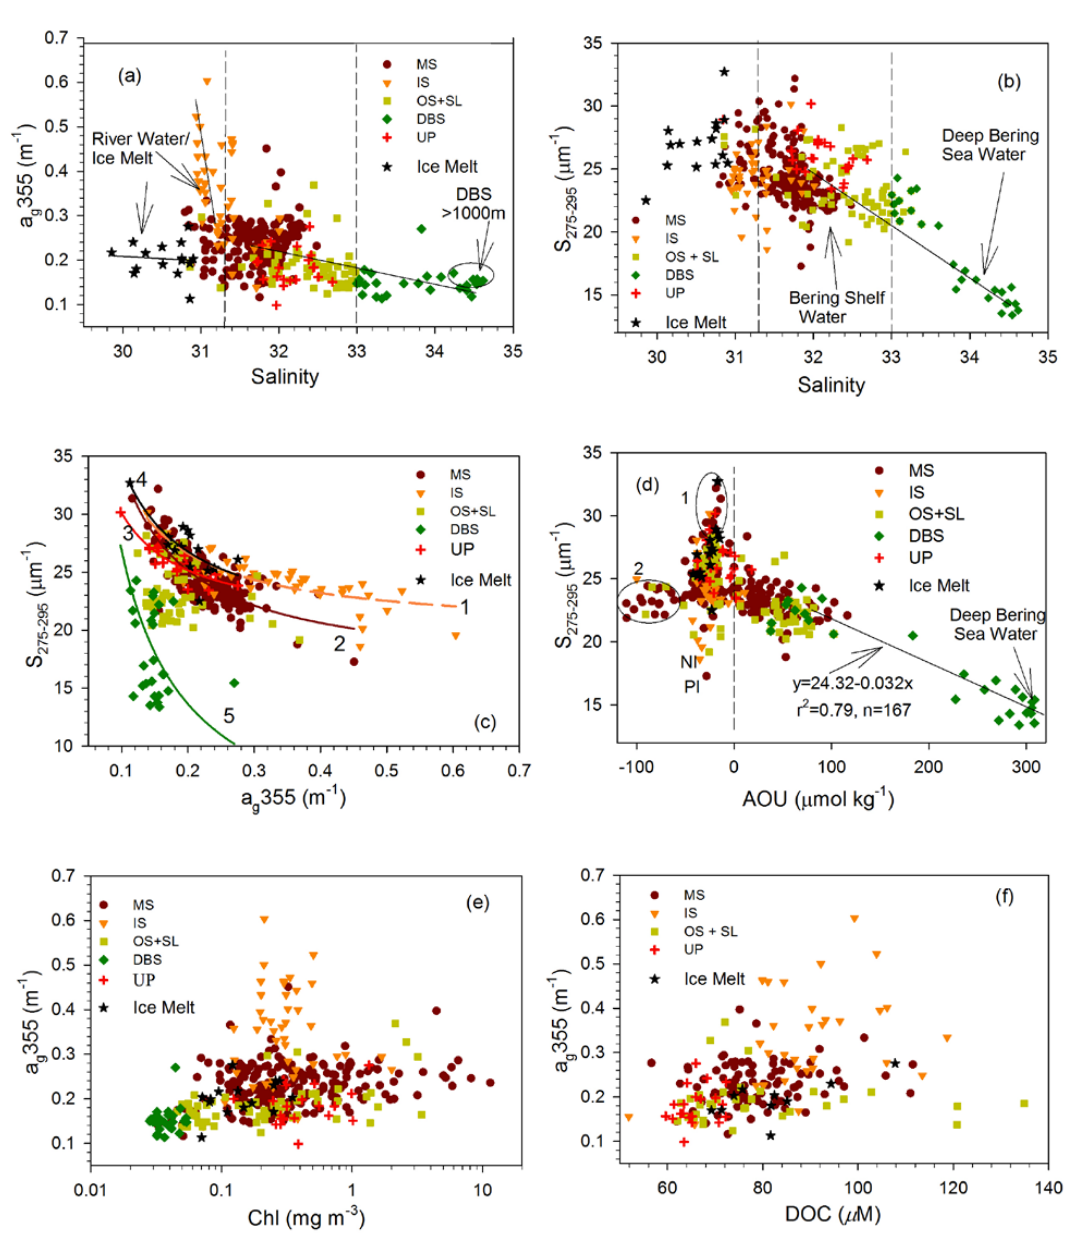
Figure 2. Relationships between (a) salinity and CDOM absorption coefficients at 355nm ( a g 355) (ellipse includes slope samples in the deep Bering Sea at at depths > 1000m), (b) salinity and spectral slope ( S or S 275 − 295 ), (c) a g 355 and S , (d) Apparent Oxygen Utilization (AOU) and S 275 − 295 , (ellipse 1 includes surface samples and ellipse 2 subsurface at Chl maxima in the northern middle shelf; NI and PI represent Nunivak and Pribilof Islands, respectively) (e) chlorophyll (Chl) and a g 355, and (f) DOC and a g 355. The abbreviations MS, IS, OS, SL, and UP represent the middle shelf, inner shelf, outer shelf, slope and Unimak Pass regions, respectively. DBS represents the deep Bering Sea water with salinity in the range 33–35; the Bering Shelf water salinity ranged from 31.3–33 (dashed